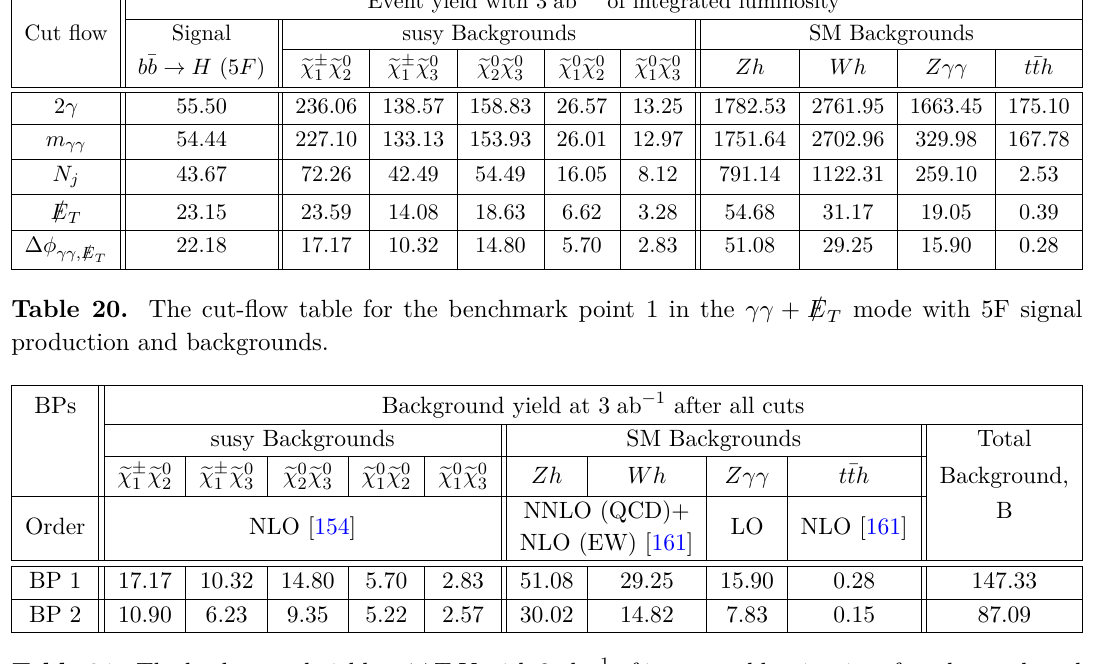
Table 21. The background yield at 14 TeV with 3 ab − 1 of integrated luminosity after the cut-based analysis for the two benchmark